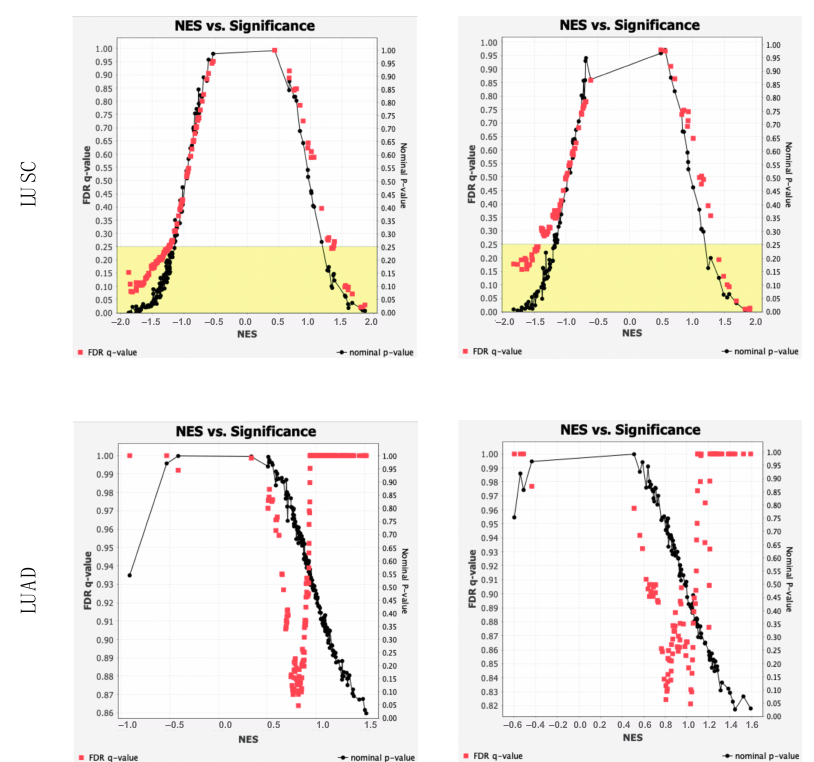
Figure 6. GSEA Significance Plots. Displays of pathway NESs with associated nominal p-values (black) and FDR q-values (red) for LUAD and LUSC analyses. Division of oncogenic associated and metabolomic associated signaling pathways. Signaling pathways of the left and right extremes of graphs exhibit the greatest extent of dysregulation, while signaling pathways of the bottom portion are of the greatest significance. Yellow shaded region signifies q-values below 0.25.